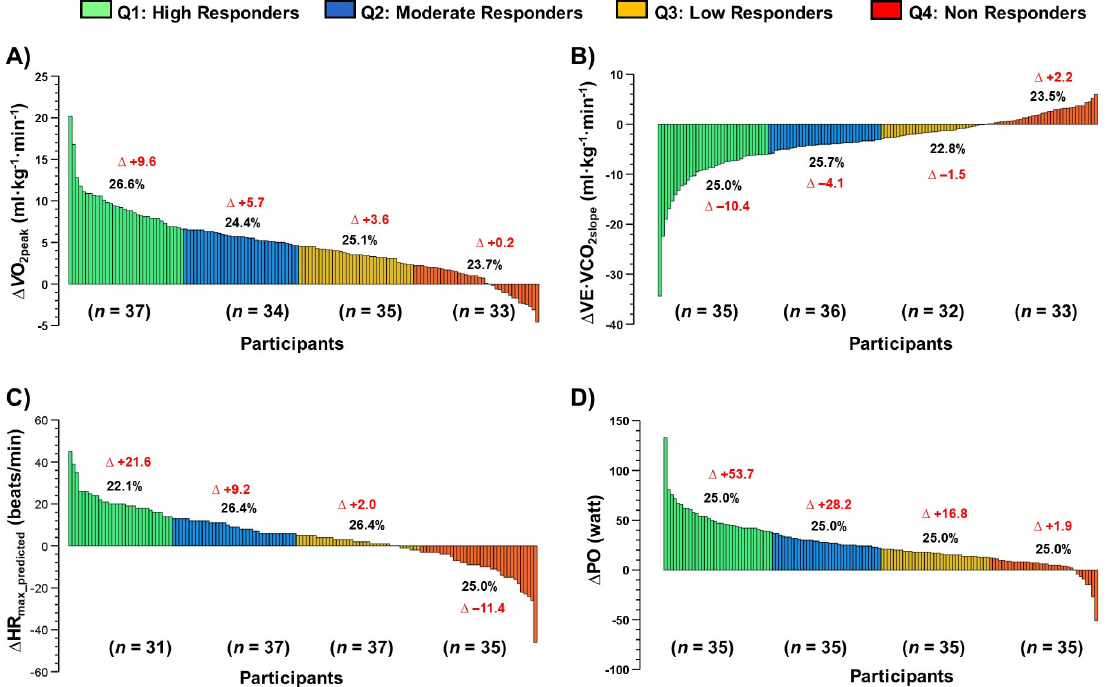
Figure 4. Interindividual variability to cardiorespiratory and performance outcomes (panel ( A )) peak oxygen consumption [VO 2peak ], (panel ( B )), slope of the ventilation minute and carbon dioxide volume ratio [VE · VCO 2slope ], (panel ( C )) heart rate maximum [HR max ], and (panel ( D )) maximal power output [PO]. Red values denote ‘average’ delta change by each quartile. Black values denote the percentage of sample of each quartile.